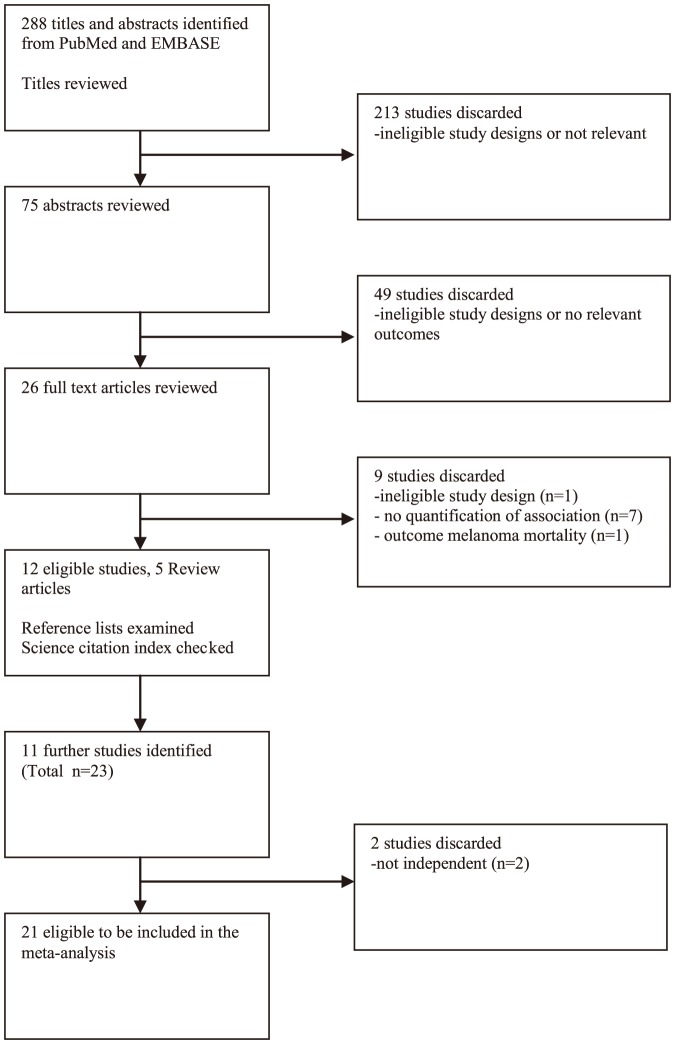
Flow chart of literature search for studies on the association between HIV/AIDS and risk of melanoma.